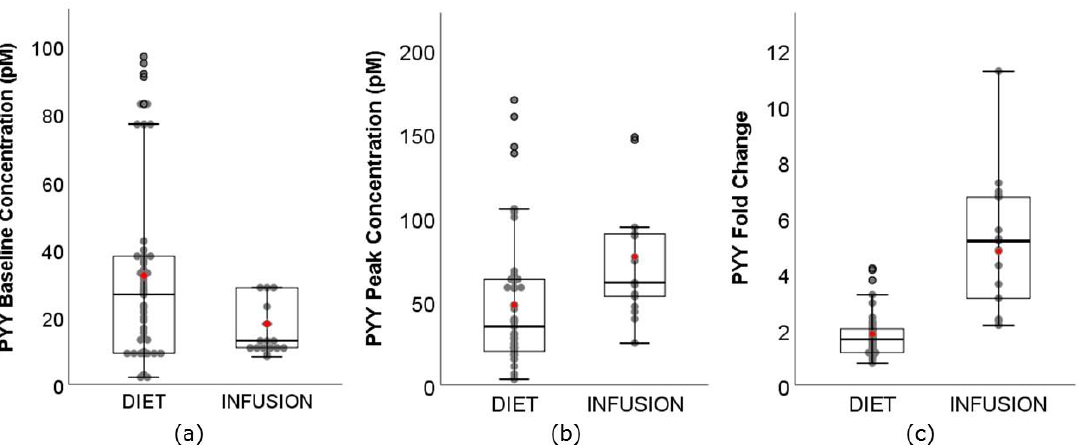
Figure 7. Boxplots showing ( a ) baseline concentration, ( b ) C max , peak concentration, and ( c ) fold change of PYY between DIET (N = 804, K = 50) and INFUSION (N = 132, K = 15). The weighted means were significantly different between DIET and INFUSION for all ( p < 0.01, all).